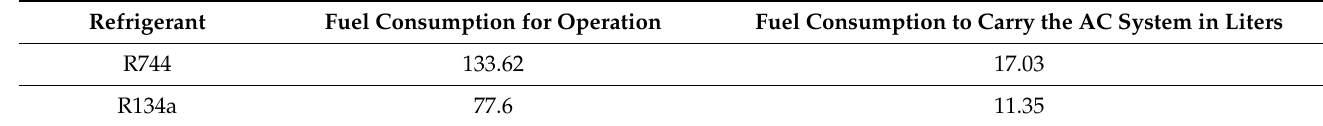
Table 5. Fuel consumption to operate and carry the AAC